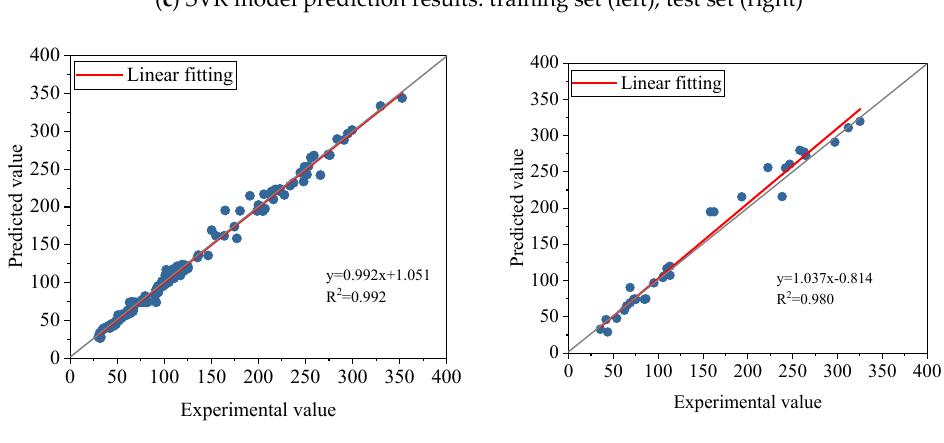
( c ) SVR model prediction results: training set (left), test set (right)